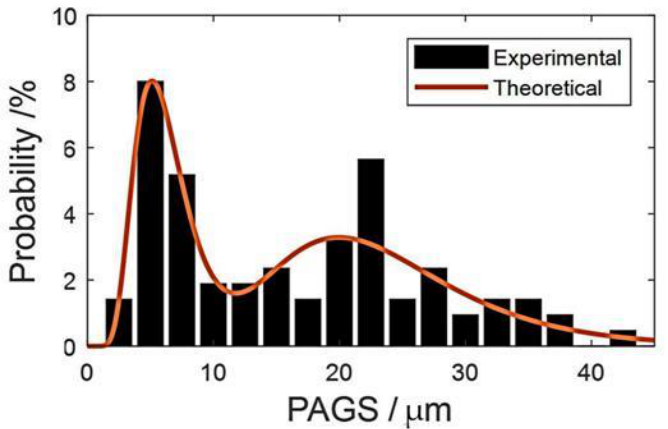
Figure 5. Prior austenite grain size (PAGS) probability distribution, in which the theoretical prob- ability distribution, fitted as a bimodal lognormal function, is overlaid. From the fitted distribution, the statistical variables were calculated and are shown